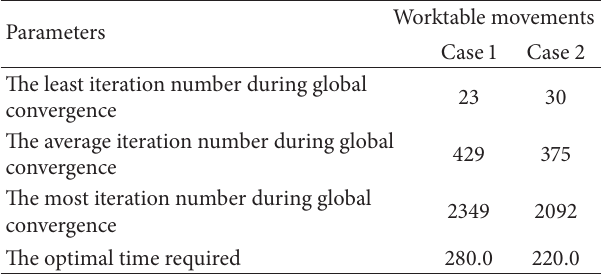
Table 2: Verification results for workpiece 2.